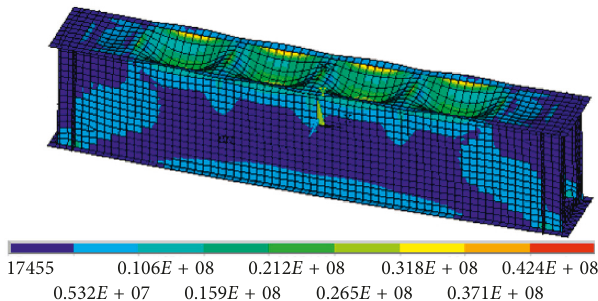
Figure 17: The von Mises stress nephogram of the narrow girder in air outlet side (Pa).